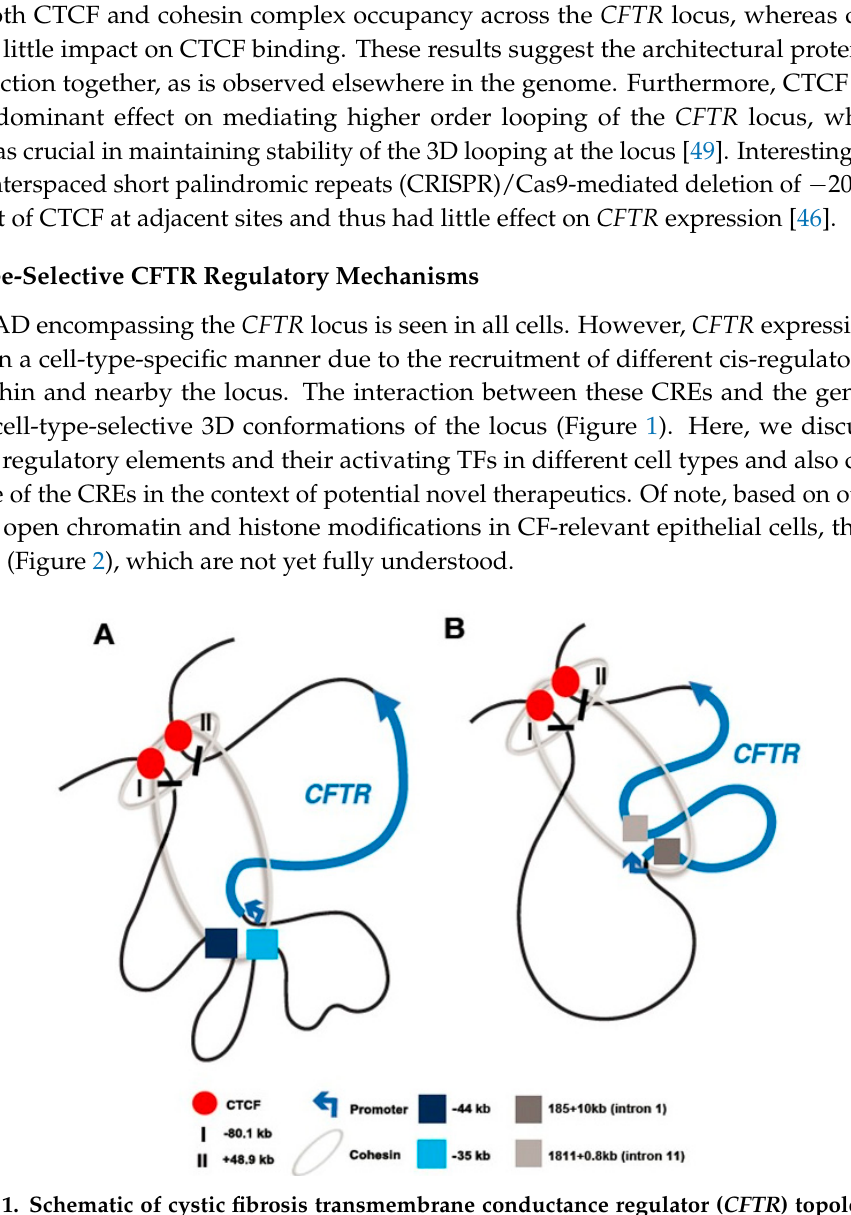
Figure 1. Schematic of cystic fibrosis transmembrane conductance regulator ( CFTR ) topologically associated domain (TAD) in airway and intestinal cell types. CFTR promoter (blue arrow) and gene are shown. TAD boundaries are denoted as “I” ( − 80.1 kb) and “II” (+48.9 kb). Occupancy of CCCTC-binding factor (CTCF) at the TAD boundaries is shown as red circles. Cohesin complex is shown as gray rings. ( A ) Airway-selective enhancer elements at − 44 kb and − 35 kb are shown by dark and light blue boxes, respectively. ( B ) Intestine-selective enhancer elements at 185 + 10kb (intron 1) and 1811 + 0.8kb (intron 11) are shown by dark and light gray boxes, respectively. Figures are not drawn to scale.